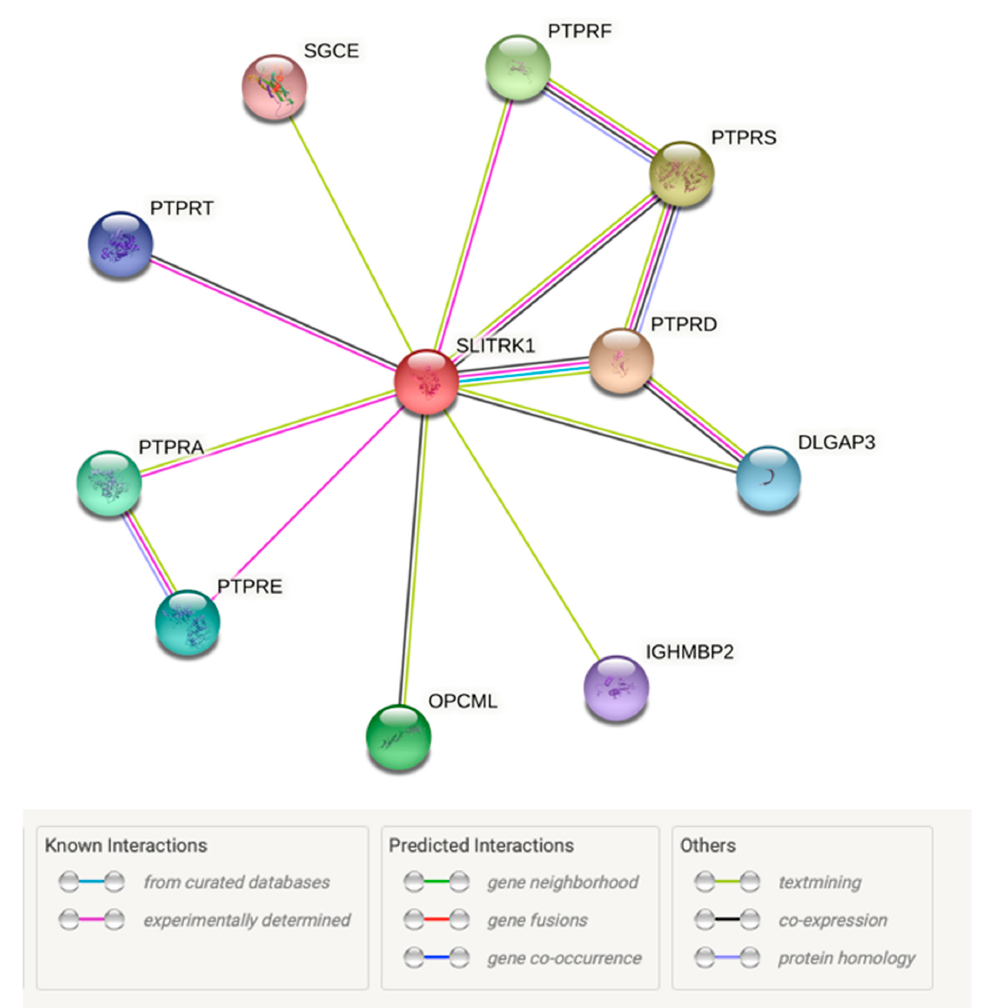
Figure 6. Prediction of protein–protein interaction using STRING.